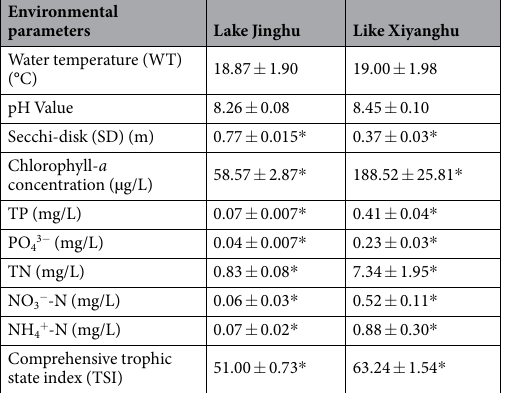
Table 1. Annual average values of physico-chemical factors and TSI ( ± SE) in Lake Jinghu and Lake Xiyanghu. ( * P <